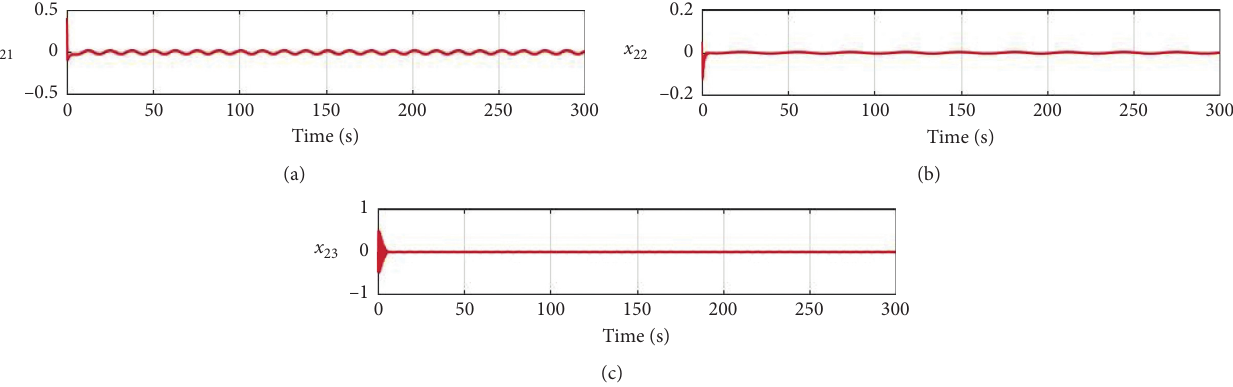
Figure 4: Trajectory of velocity vector x